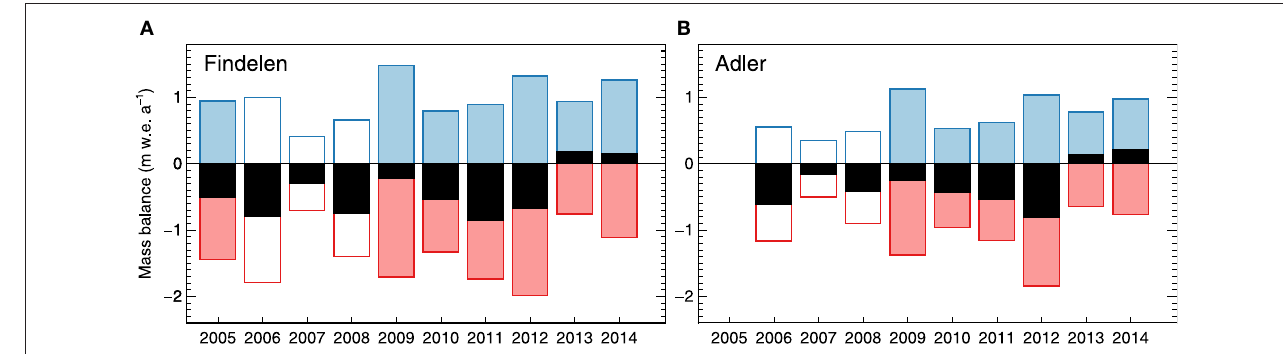
FIGURE 7 | Evaluation of summer (red), winter (blue), and annual (black) mass balance of (A) Findelengletscher and (B) Adlergletscher based on the model-based extrapolation approach. Unfilled bars indicate mass balances that were not constrained by observations of winter snow accumulation.